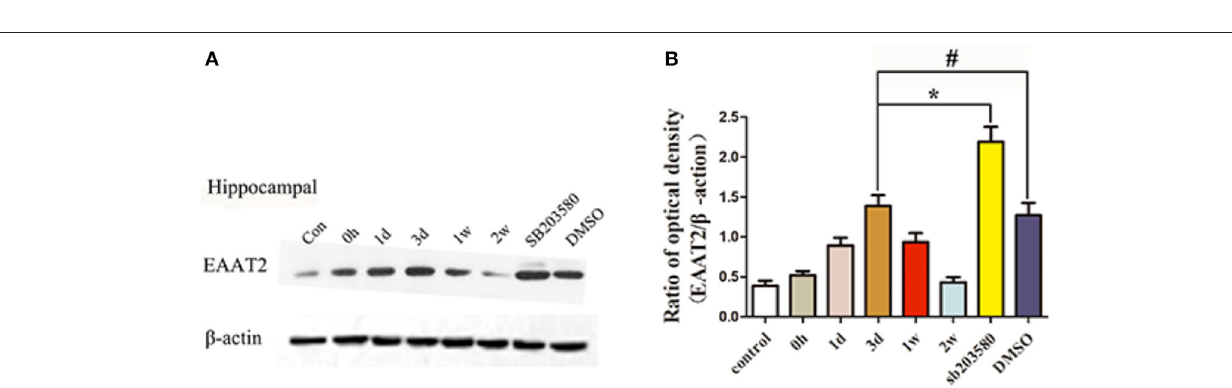
EAAT2-positive cells. The number of EAAT2-positive cells in the seizure group at 3 d was significantly increased ( P < 0.05) compared with that in the untreated control group. Moreover, the